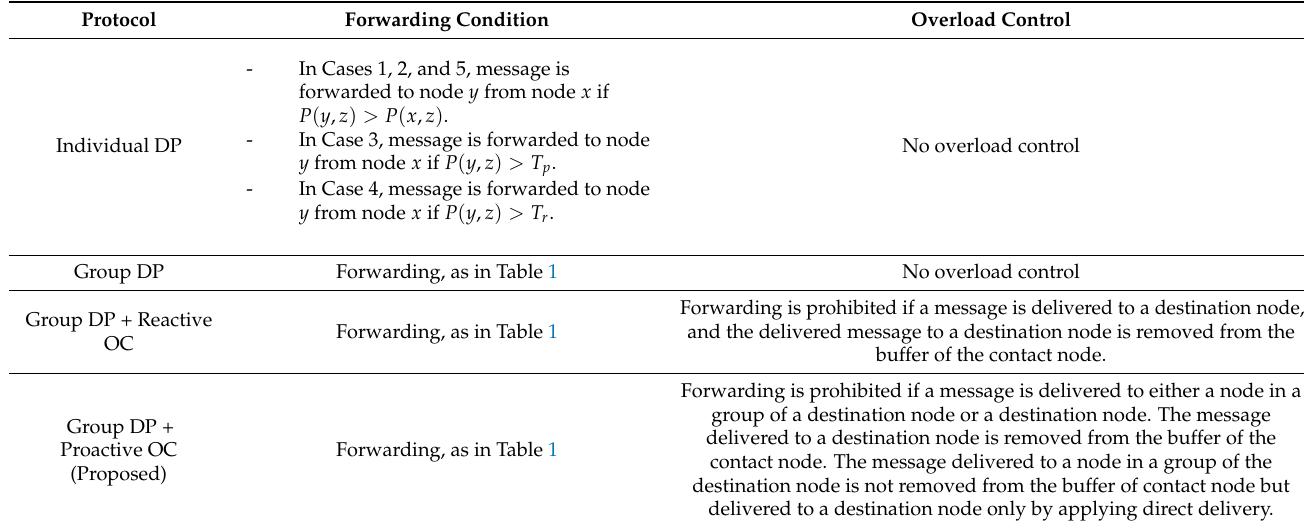
Table 4. Comparison of the proposed protocol with comparable